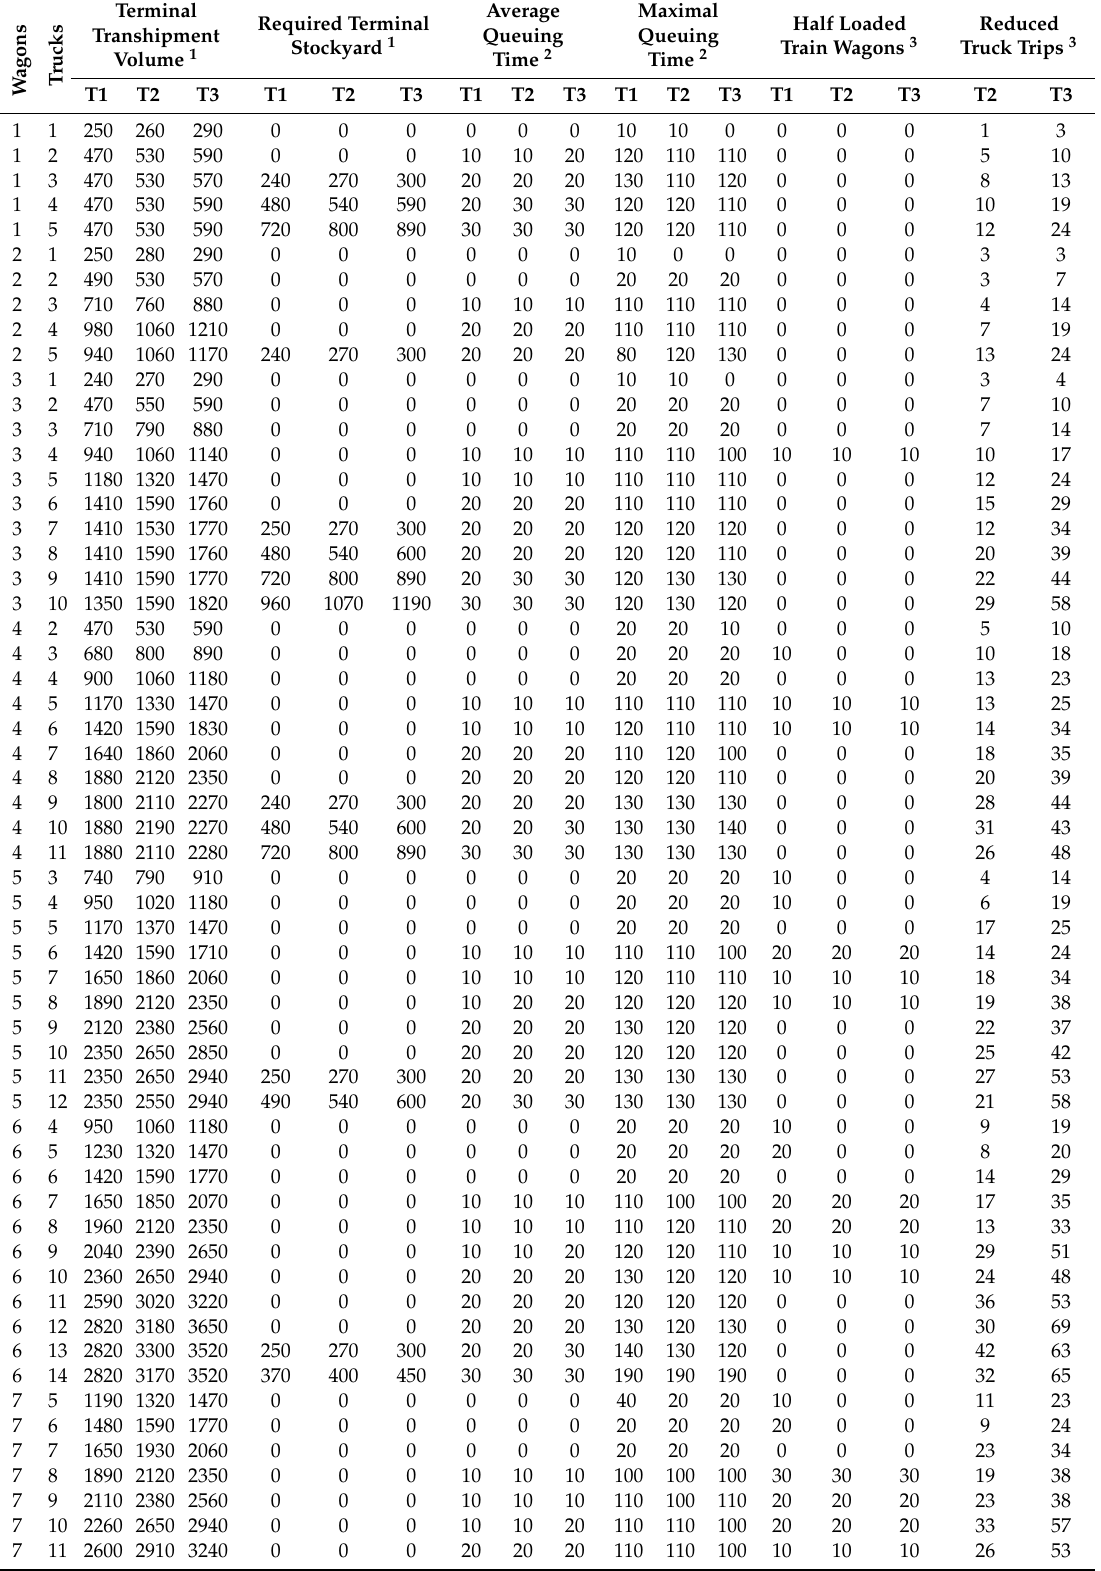
Table A5. Terminal transport template for two train pick-ups, medium delivery time, and all tonnages (P2D2 T1 / 2 /